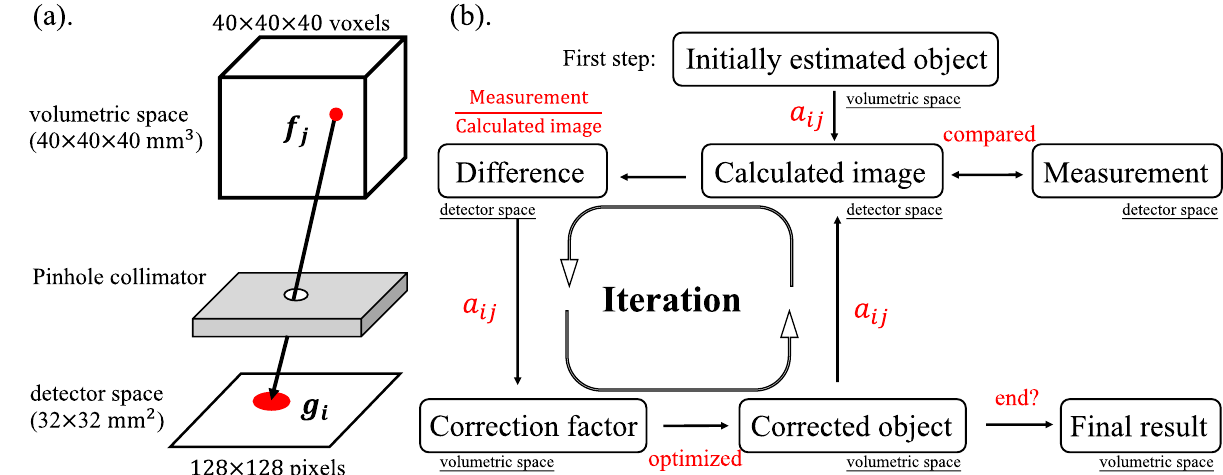
241 Am. ( b ) Maximum